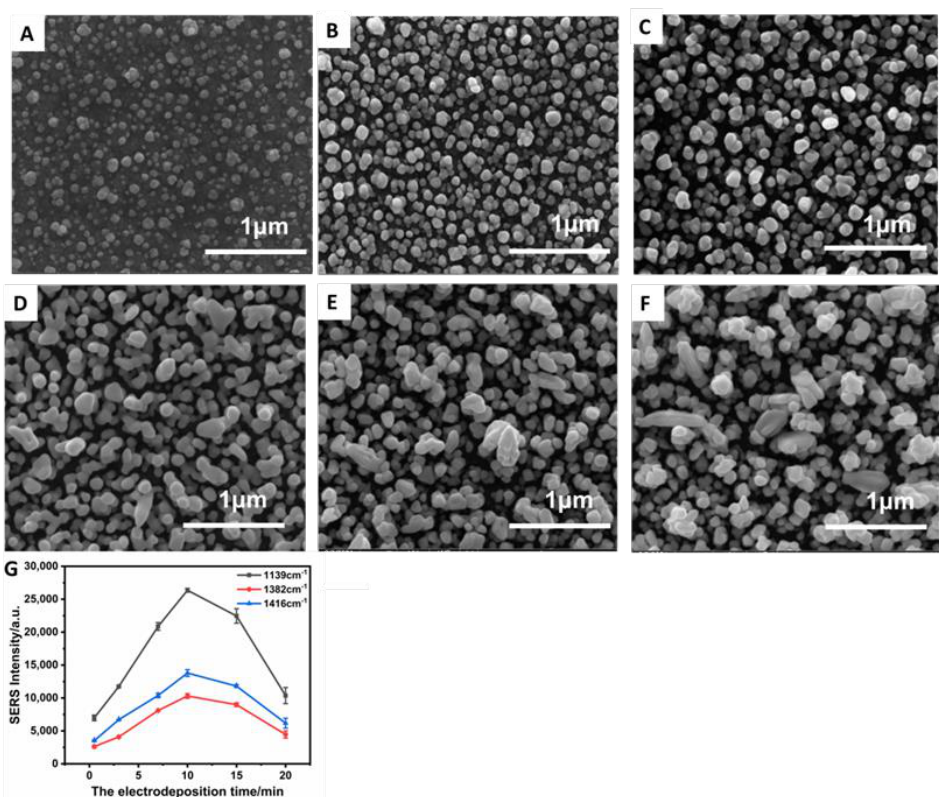
Figure 2. SEM images of AuNPs formed on the ITO surface for different deposition times of ( A – F ) (0.5, 3, 7, 10, 15, and 20 min) at − 0.6 V deposition potential in 5 mM HAuCl 4 and 0.5 M H 2 SO 4 solution; ( G ) effect of deposition times on the SERS intensity. The error bars were derived from the relative standard deviation (RSD) of five measurements.